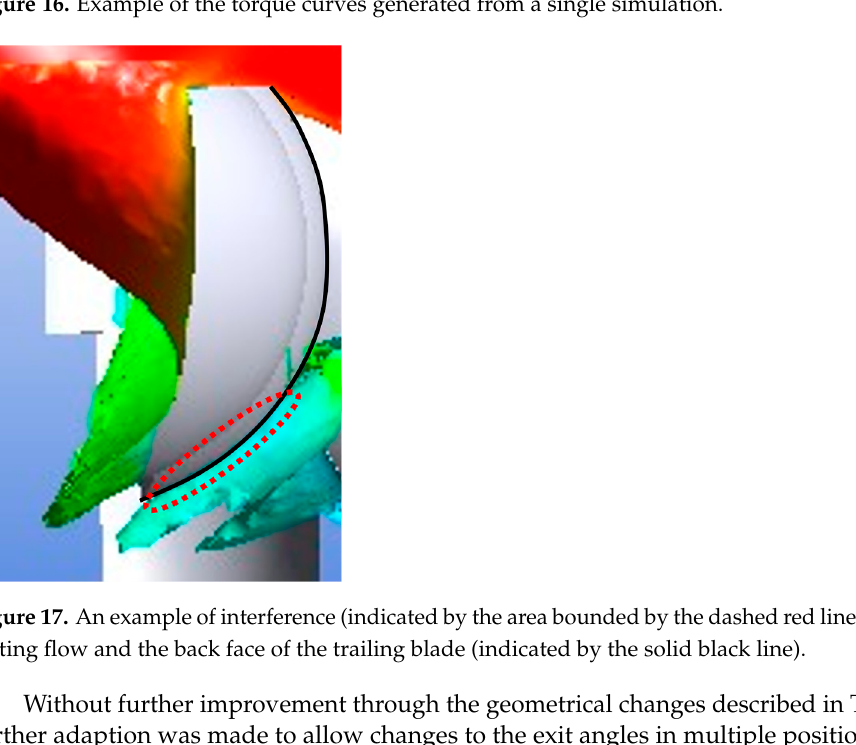
Figure 18. Distribution of interstitial planes over half of the blade. In order to investigate the trade-off that occurred between exit angles that focused flow towards the center of the blade and those that tended to result in a more even flow film leaving the blade, two blades were generated with inverted distributions of angles going from the center to the outside edge. One blade had angles that increased from the